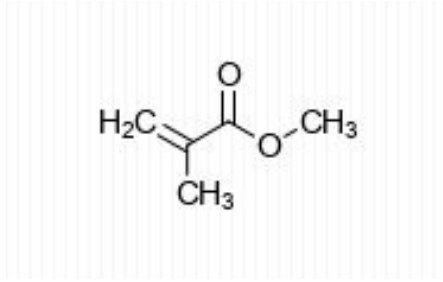
Figure 1. Methyl methacrylate (MMA) structure.